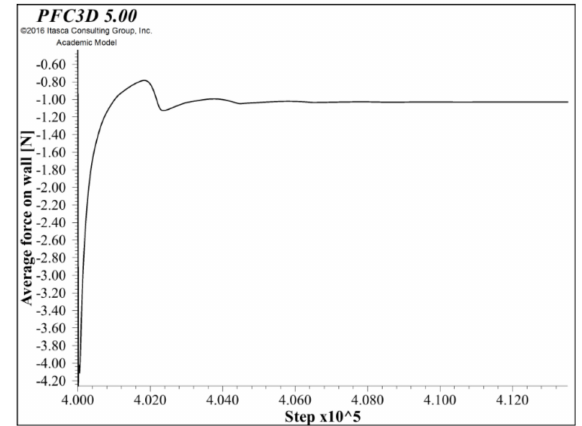
Figure 7. Characteristic time for the full-sized 3D sample.